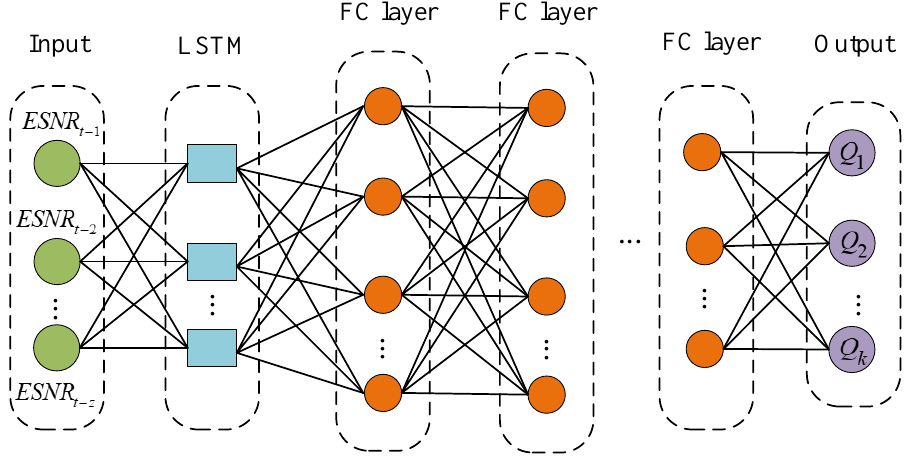
Figure 5. The LSTM-DQN network